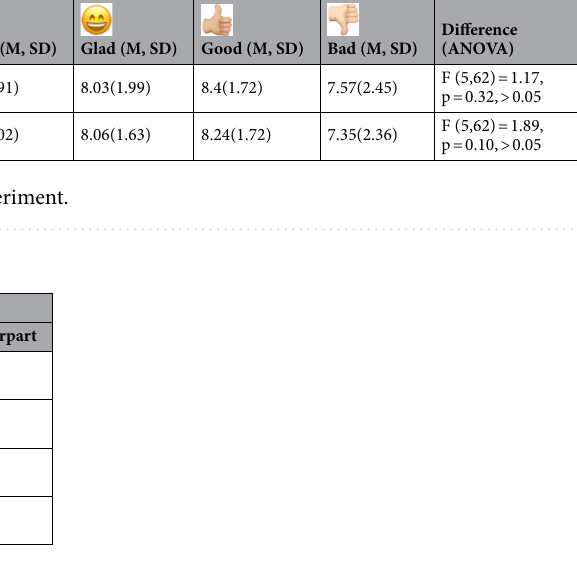
Table 2. Target emojis and their verbal counterparts in matched and unmatched conditions.